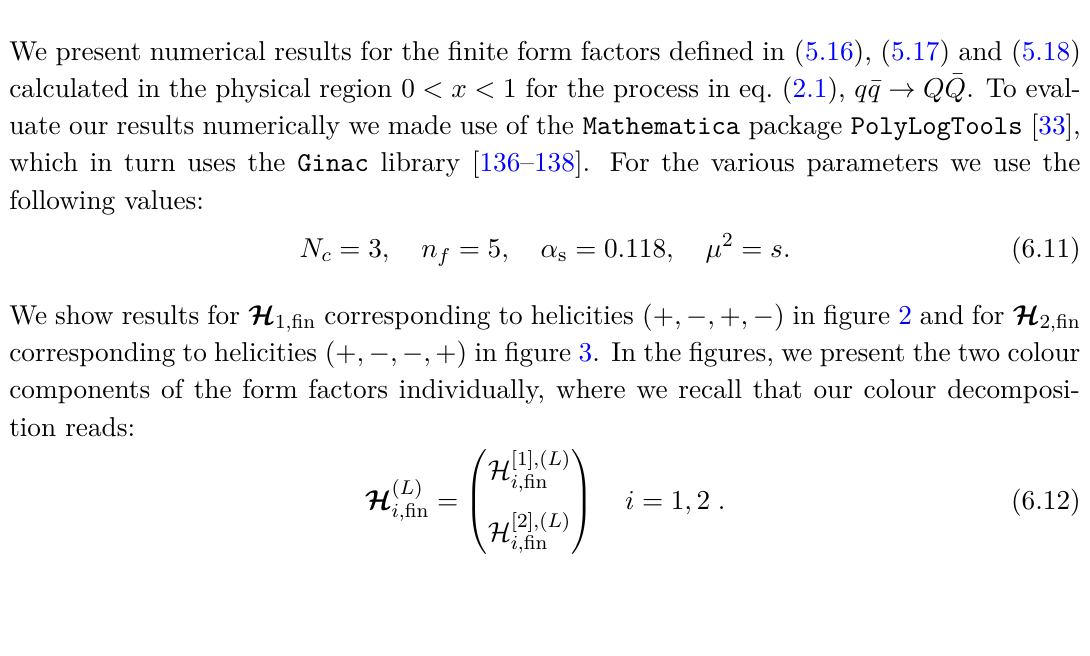
Figure 2 . Real (left) and imaginary (right) parts of the form factors H [ i ] , ( L ) (+ , − , + , − ) . Colour components [ i ] and number of loops ( L ) are specified in the legends.